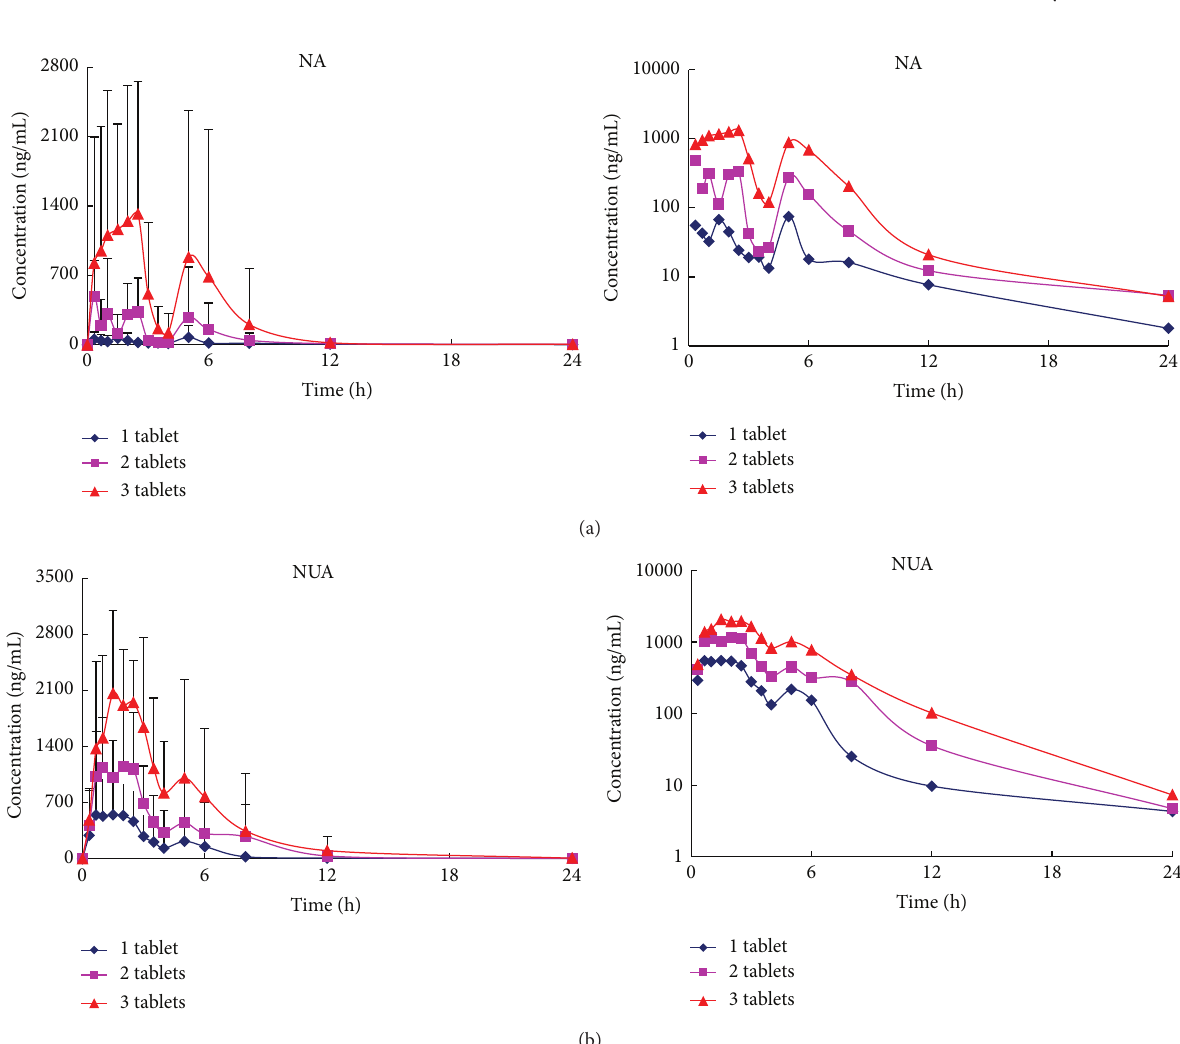
Figure 3: Mean plasma concentration-time profiles and logarithmic transformation profiles of NA (a) and NUA (b) after oral single dose administration of Niacin extended-release/Simvastatin (1 tablet 500 mg/10mg, 2 tablets 1000 mg/20 mg, and 3 tablets 1500 mg/30mg) to volunteers ( 𝑛 = 12